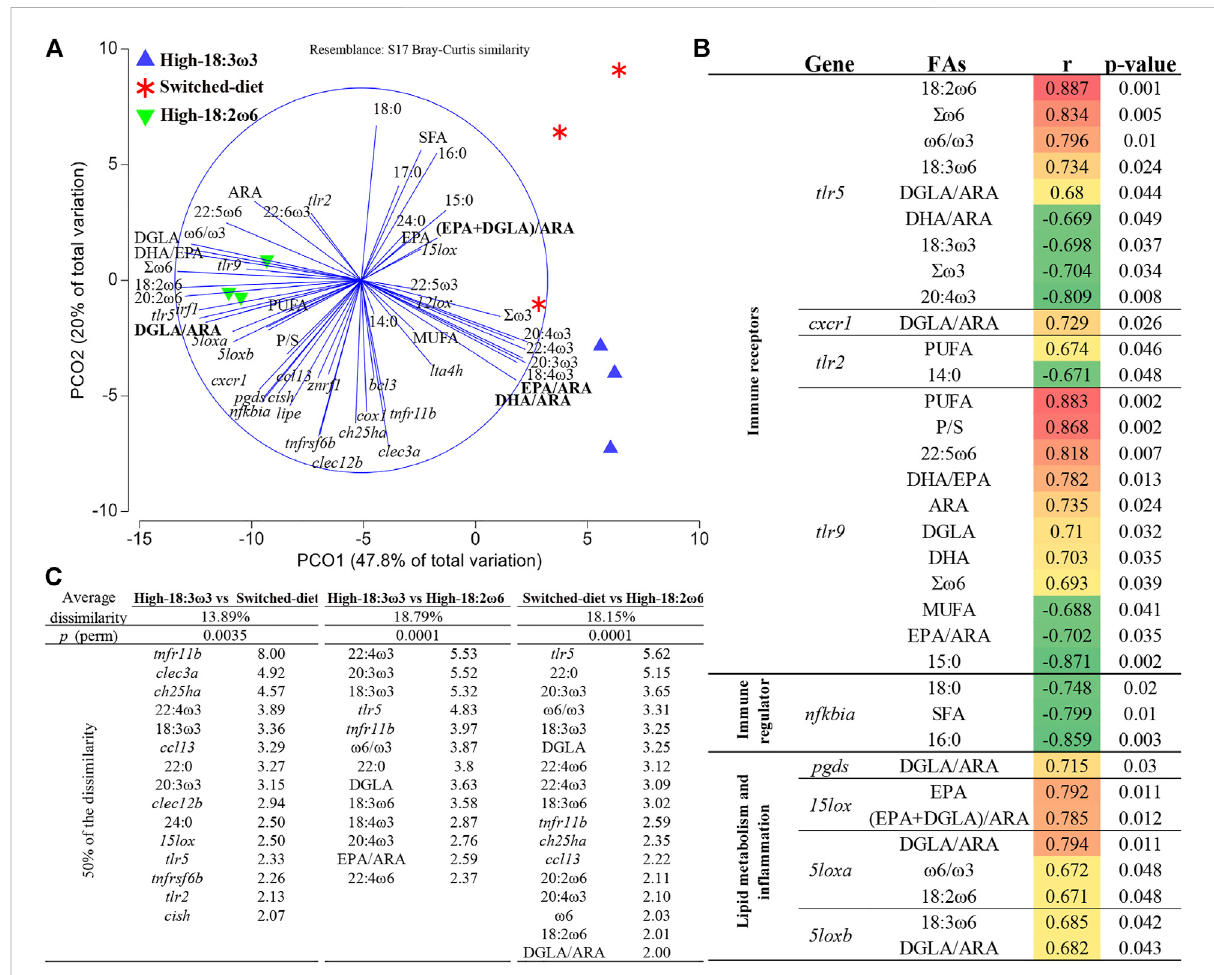
FIGURE 6 (A) Principalcoordinatesanalysis